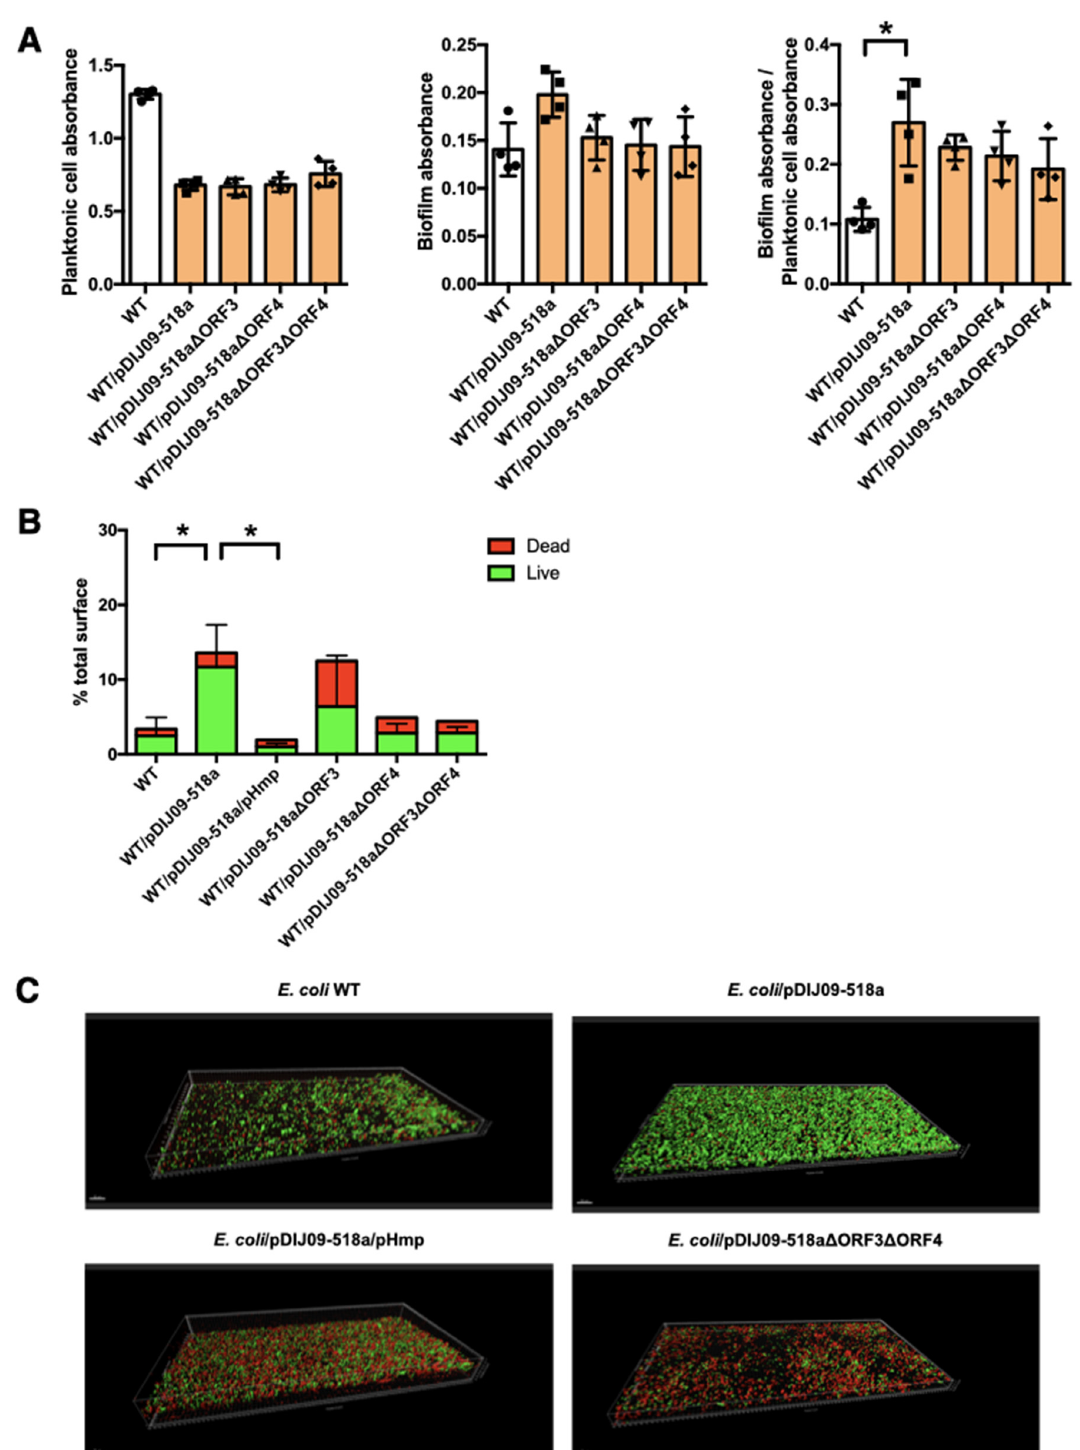
Figure 2. Aminoglycosides promote biofilm formation in E. coli carrying the small qnrD -plasmid. ( A ) Crystal violet binding assay for assessment of biofilm formation by E. coli WT (white) and its derivatives strains (orange): WT/pDIJ09-518a (carrying the native plasmid, square) WT/pDIJ09- 518a Δ ORF3 (carrying the plasmid deleted for ORF3, upward triangle), WT/pDIJ09-518a Δ ORF4 (WT/pDIJ09-518a Δ orf4, downward triangle) and WT/pDIJ09-518a Δ ORF3 Δ ORF4 (carrying the plasmid deleted for both ORF3 and ORF4, diamond). Left panel, crystal violet planktonic absorb- ance (OD 600 ). Middle panel—crystal violet biofilm absorbance (OD 595 ). Right panel—biofilm index